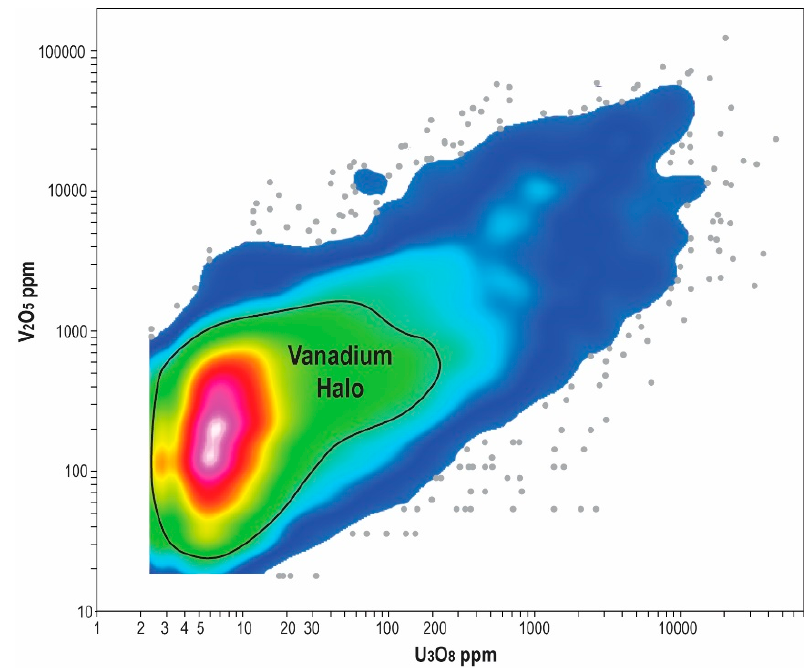
Figure 2. Density data plot showing the variation in V 2 O 5 versus U 3 O 8 assay values for 1 meter composited drillhole intervals covering the entire Bigrlyi deposit (25,300 meter-intervals in total). The vanadium-rich halo is associated with vanadium levels in the hundreds of ppm (up to about 2000 ppm V 2 O 5 ) but <200 ppm U 3 O 8 .